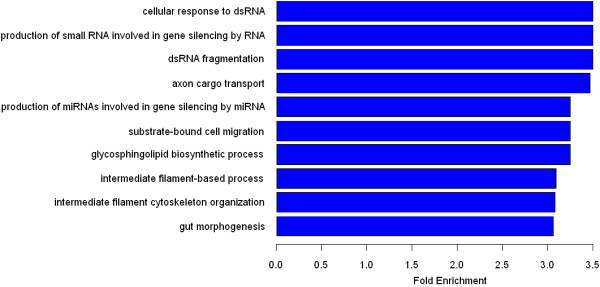
The bar plot of the GO analysis of Biological Process. The bar plot shows the top ten Fold Enrichment value of the significant enrichment terms of designated gene involving Biological Process